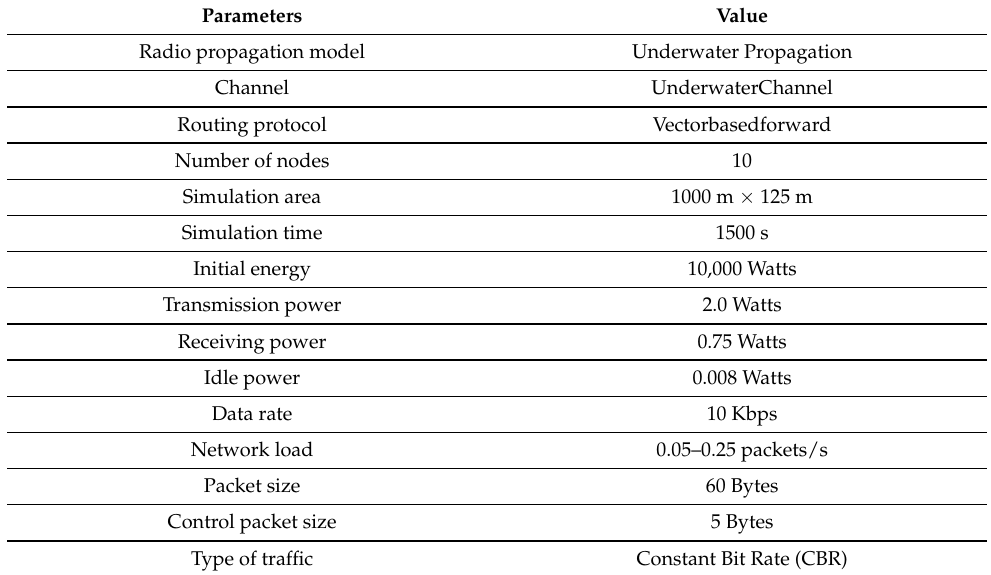
Table 6. Simulation Parameters [34] @ 2021